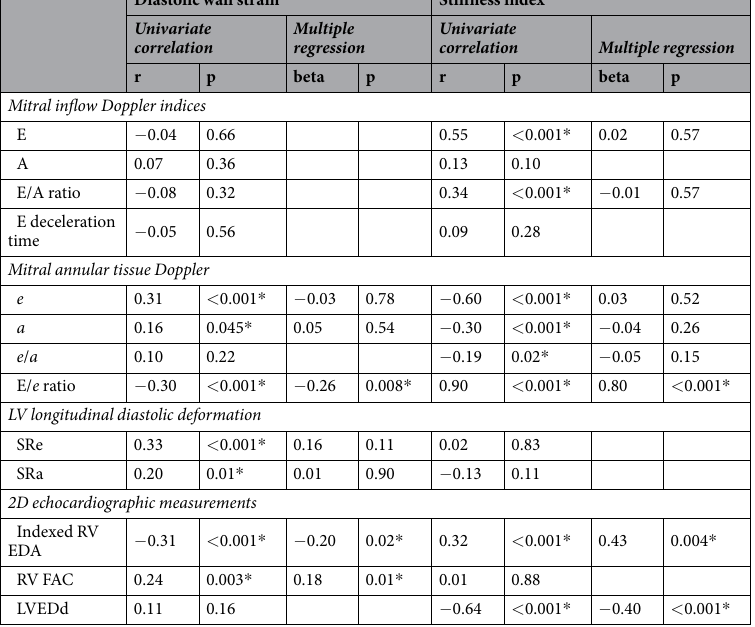
Diastolic wall strain Stiffness index Univariate correlation